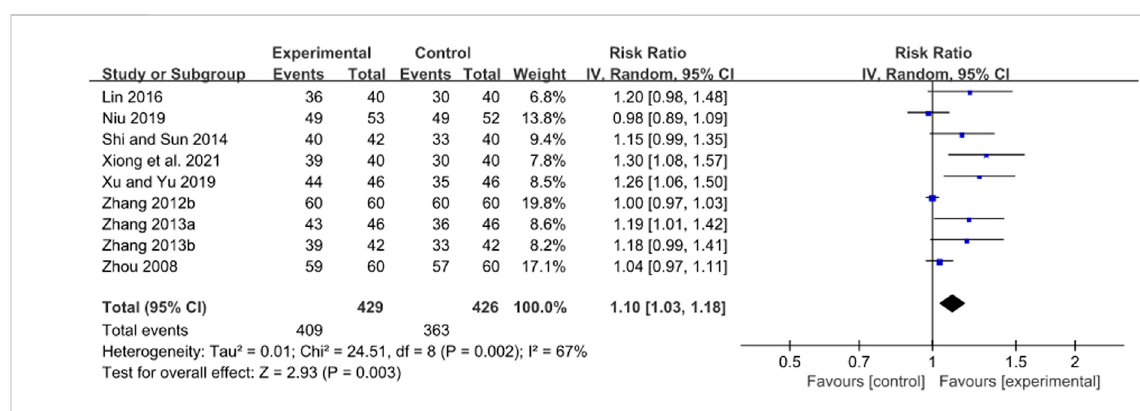
FIGURE 11 Forest plot of response rate after JWC with the duration of 4